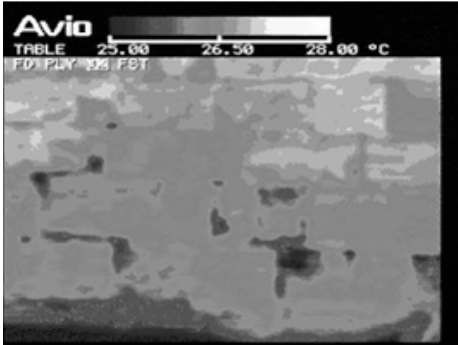
Figure 12. Thermograph of investigated masonry.